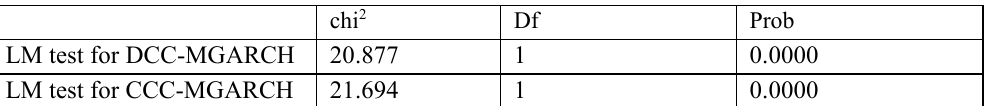
Table 4. LM Test for DCC and CCC-MGARCH of Ghana Sovereign Bond Return chi 2 Df Prob LM test for DCC-MGARCH 20.877